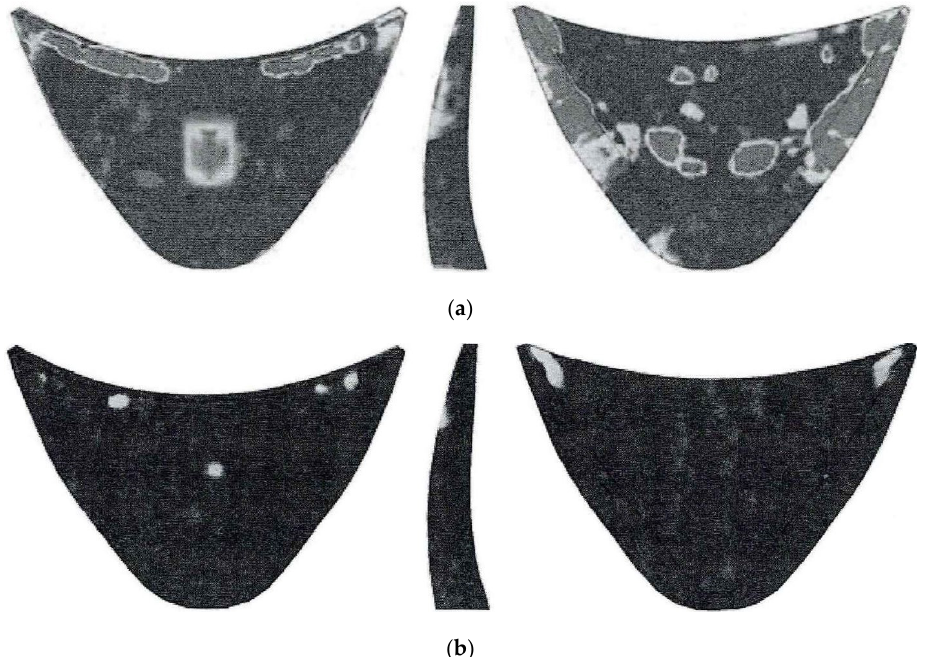
Figure 28. Arch dam damage cloud chart with 80 m underwater initiation. ( a ) Upstream surface, arch crown cantilever, and downstream surface view damage cloud chart without a foamed aluminum protective layer. ( b ) Upstream surface, arch crown cantilever, and downstream surface view damage cloud chart with a foamed aluminum protective layer.